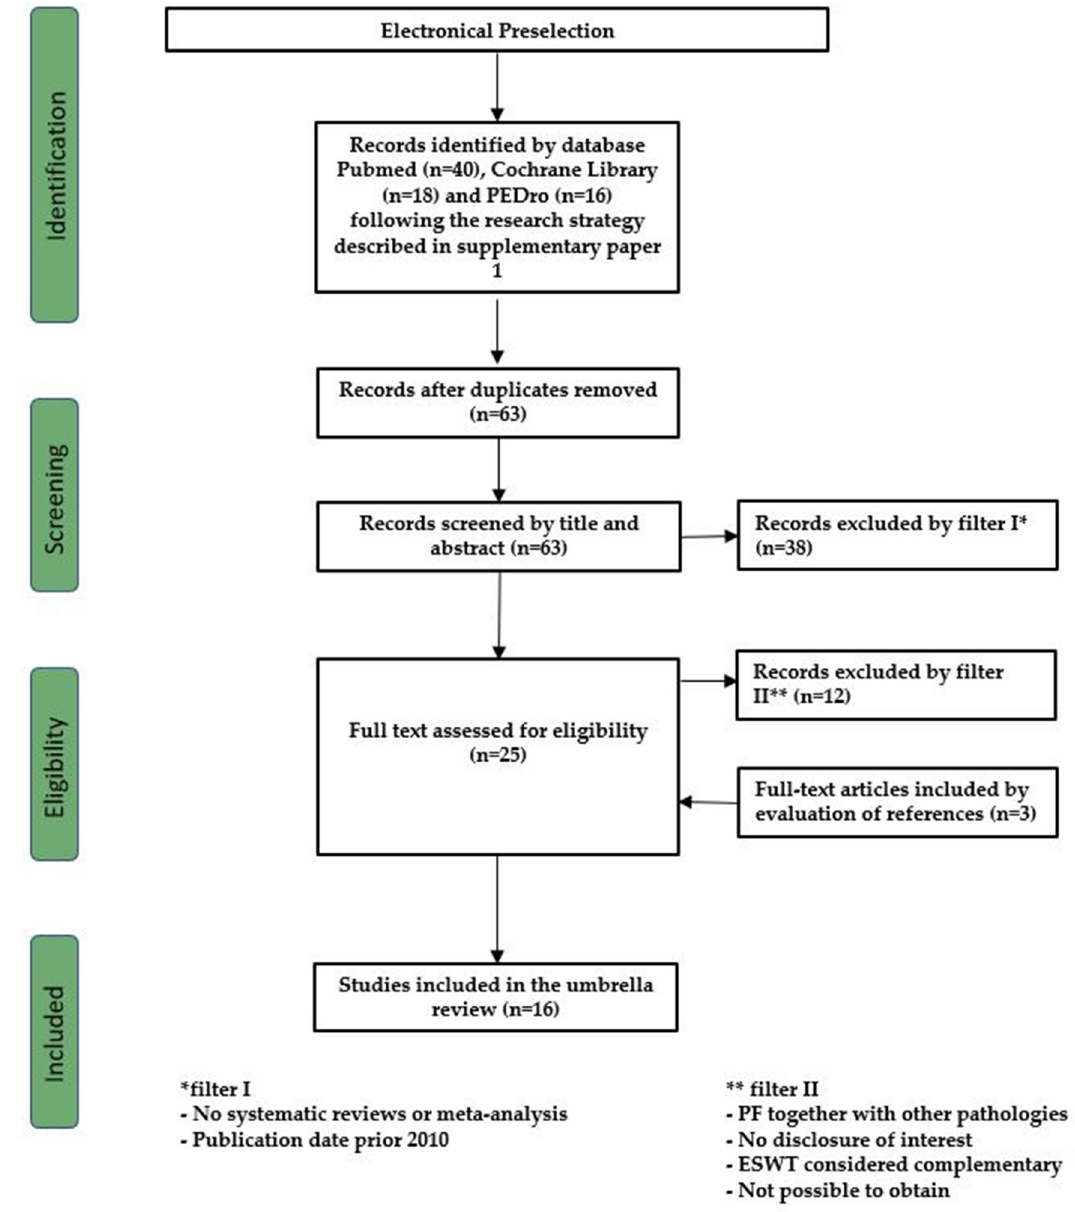
Figure 1. Flow chart.